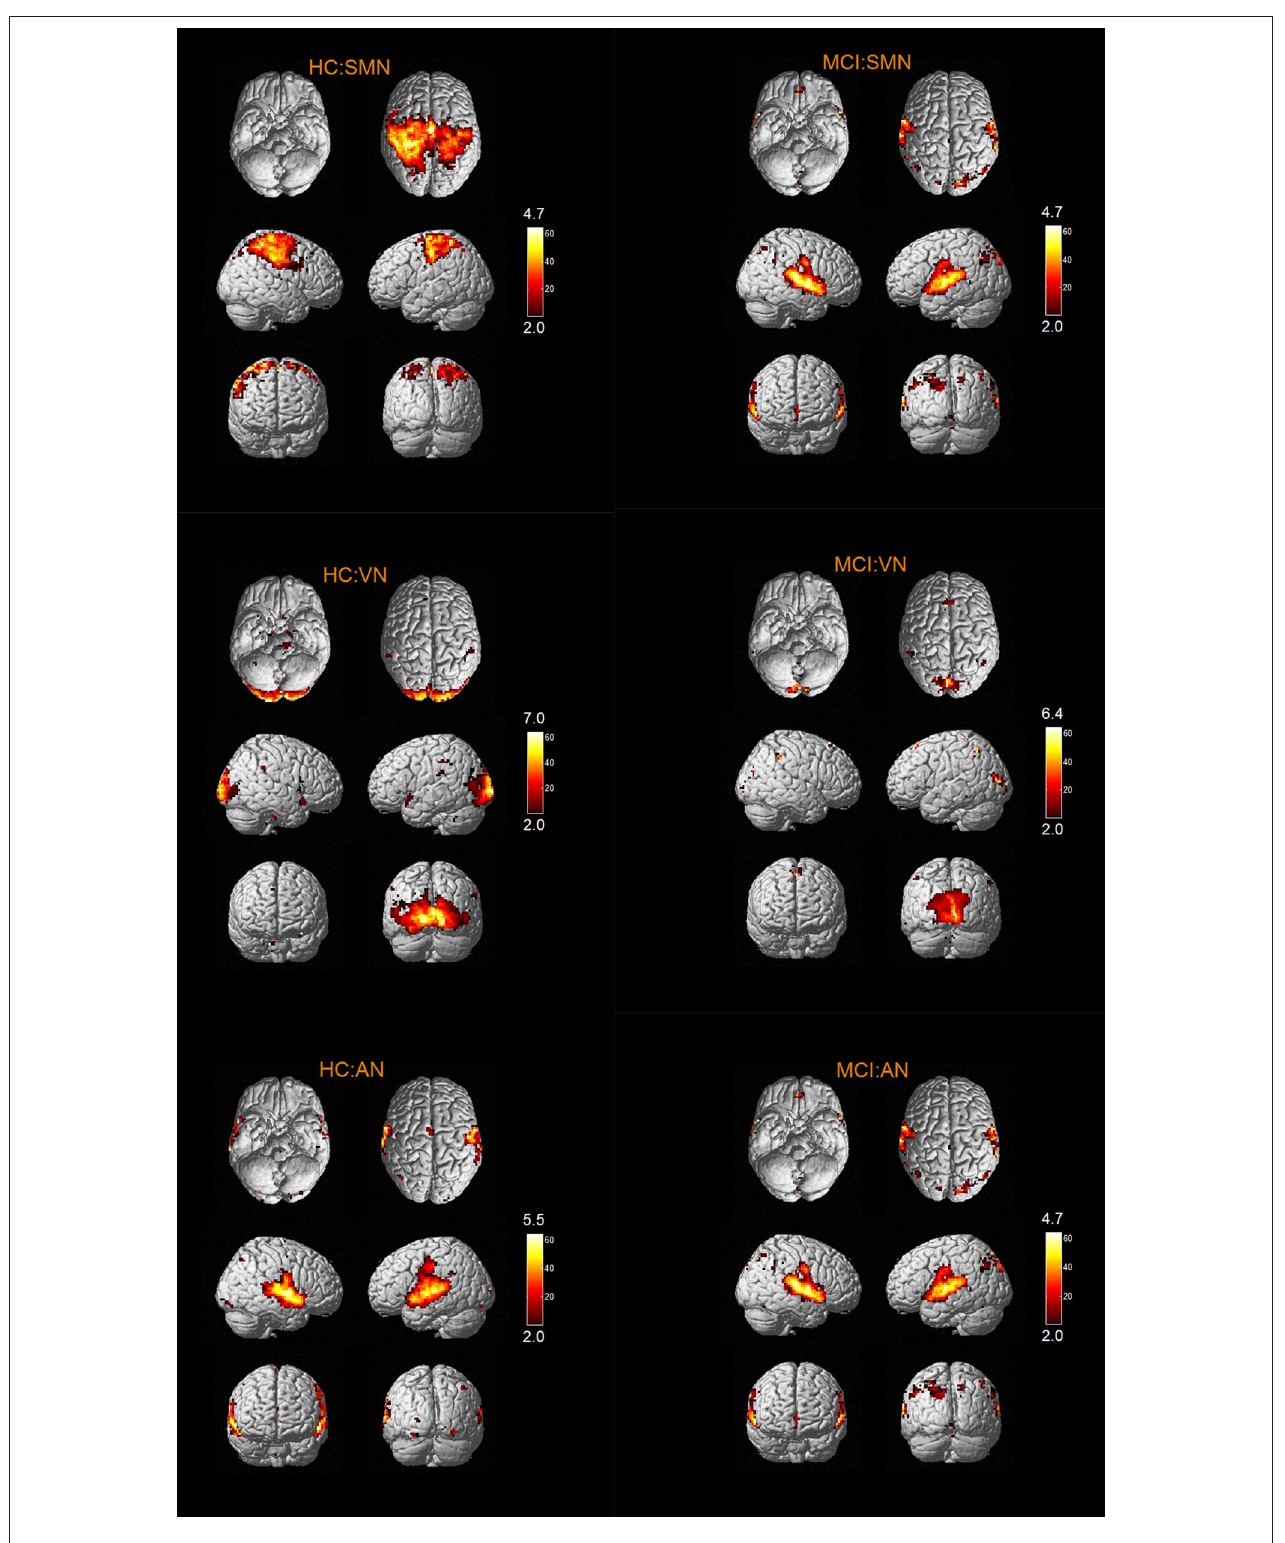
FIGURE 2 | The spatial distribution of VN, AN, DAN in MCI group and HC group.